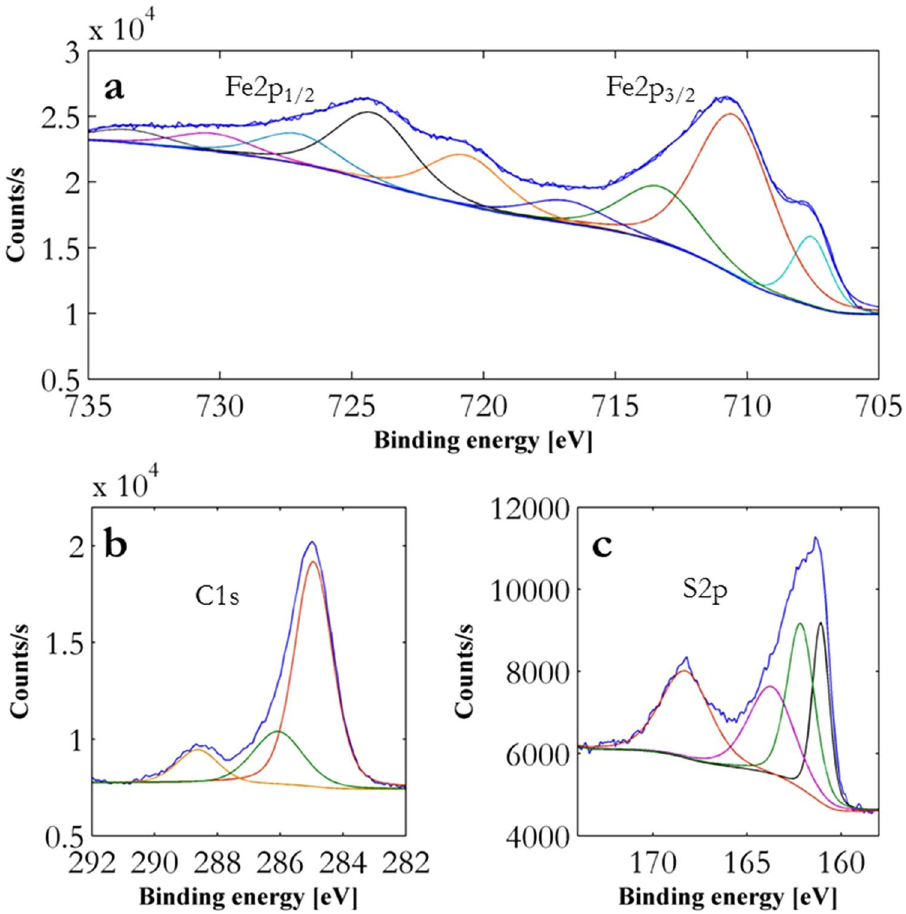
Figure 2. Representative XPS data of catalyst nanoparticles from ferrocene and thiophene at reaction conditions described in the Methods section sampled at the outlet of the reactor. The data shown is for iron ( a ), carbon ( b ) and sulfur ( c ). Raw data in navy blue and all other peaks and background were fitted according to the method described in supplementary